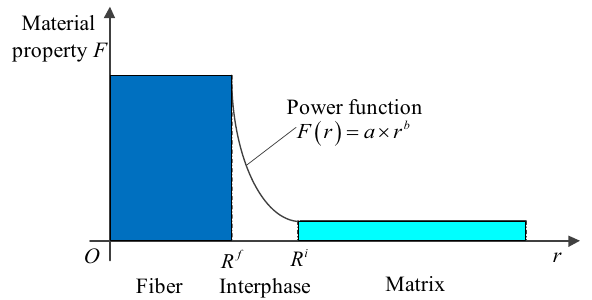
Interphase Matrix Figure 2: Gradient distribution of interphase mechanical property.